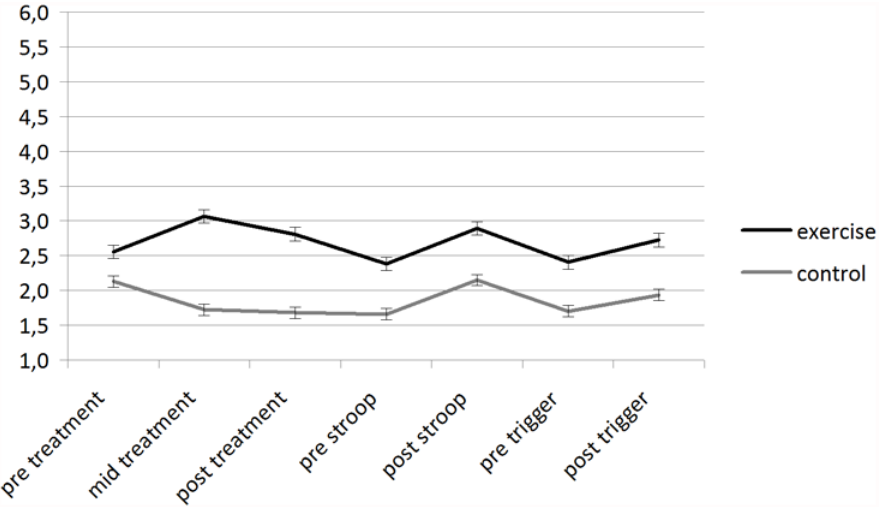
Fig 2. Mean (SEM) scores for Felt Arousal Scale for each condition over the whole duration of the session.